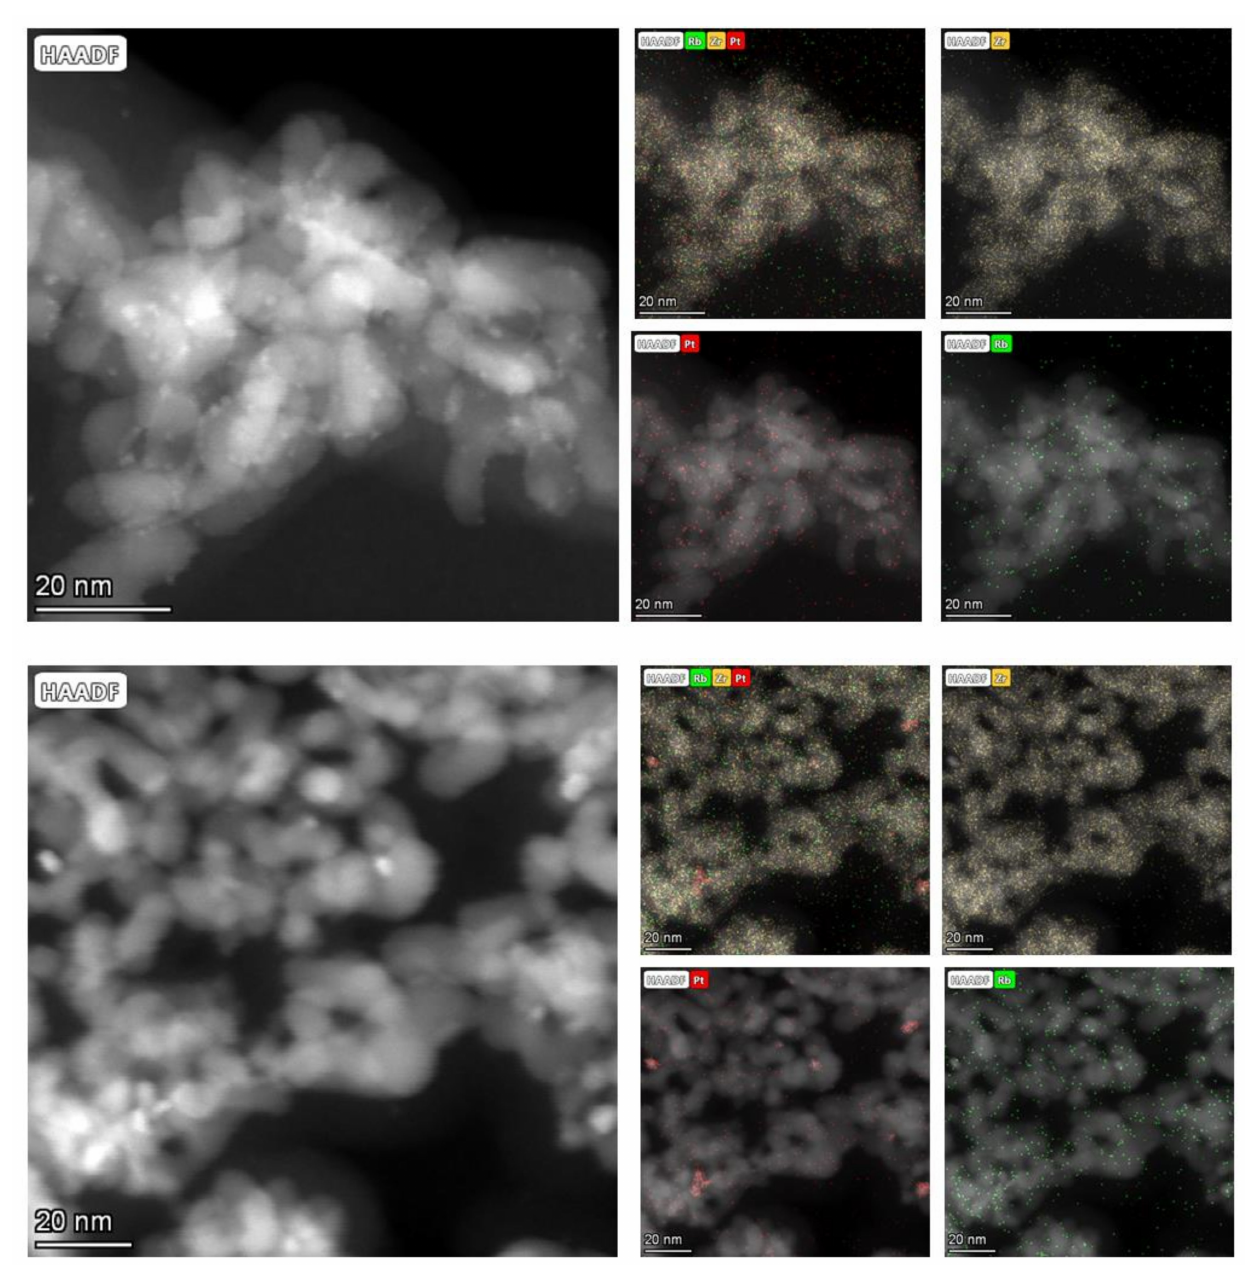
Figure 11. Transmission electron microscopy (TEM) and scanning transmission microscopy with energy-dispersive X-ray spectroscopy (STEM-EDX) images for the ( top ) 0.93%Rb-2%Pt/ZrO 2 catalyst and ( bottom ) the 9.29%Rb-2%Pt/ZrO 2 catalyst. High loadings of Rb tend to agglomerate the Pt